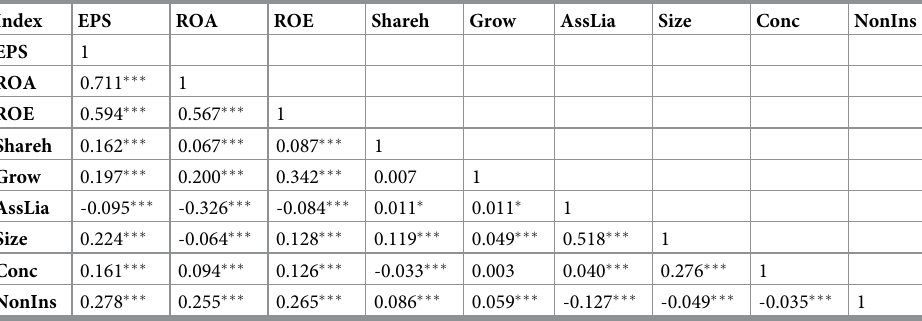
Table 3. Pearson correlation coefficient.